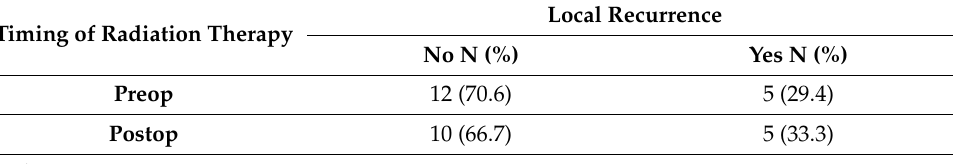
Fisher’s exact test =